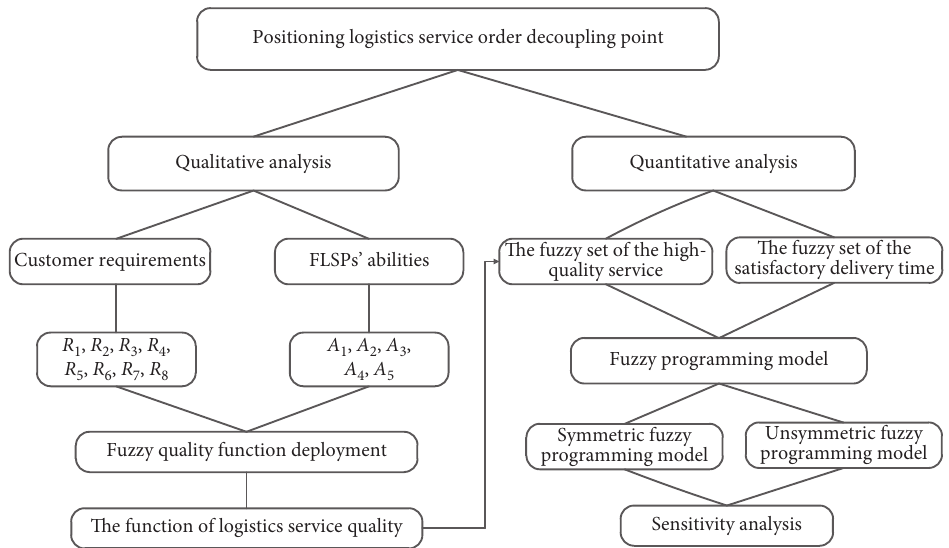
Figure 2: The proposed positioning CODP procedure. Table 2: Customer service quality factors: